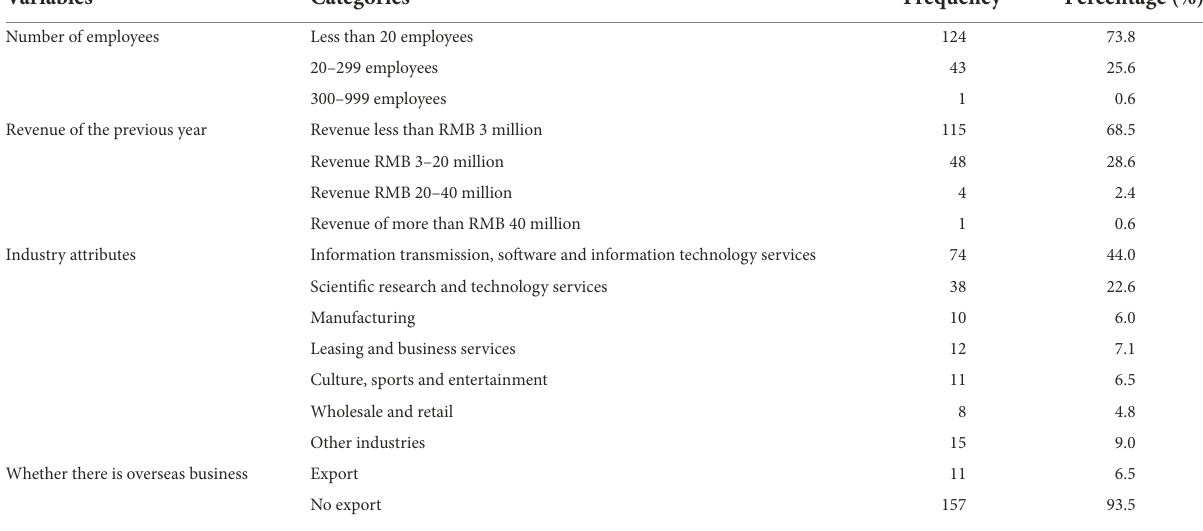
TABLE 1 Characteristics of sample